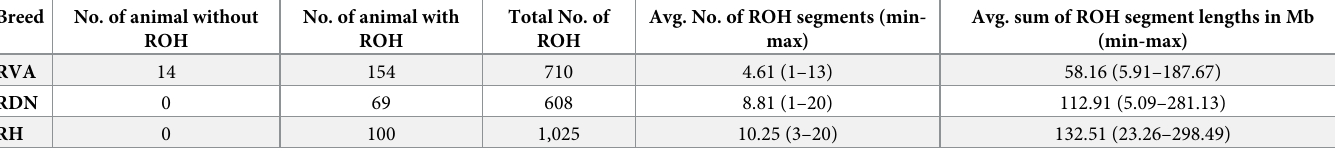
The first principal component (PC1) explained 21.2% while the second (PC2), third (PC3) and fourth (PC4) explained 17.9%, 13.4% and 9.2%, respectively of total variation in the data (Fig 5). Contrasting PC1 vs. PC2, the West African breed (BAO) was clearly separated from the rest Table 3. Number of animals with and without identified ROH, total and average number of ROH per breed and average sum of ROH segment lengths for Angler (RVA), Red-and-White dual-purpose (RDN) and Red Holstein (RH). Breed No. of animal without No. of animal with Total No. of ROH ROH